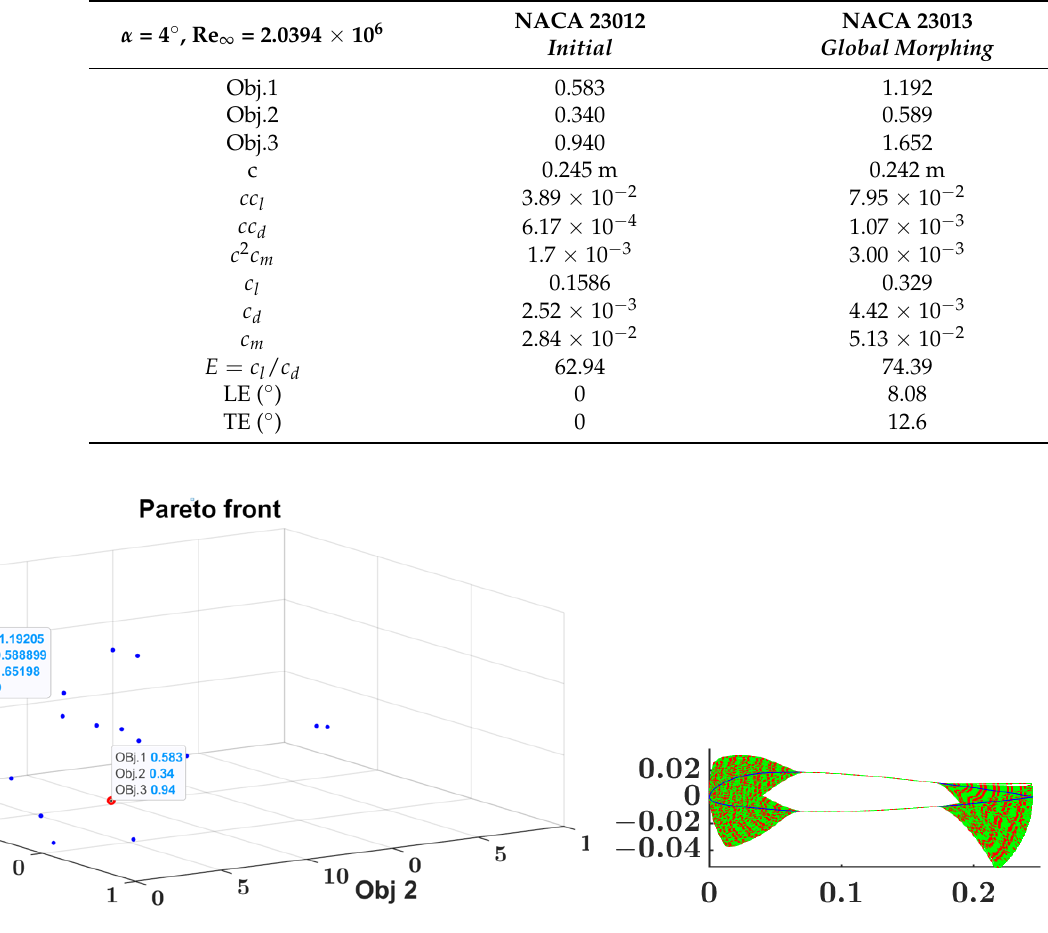
Figure 36. Objective functions Pareto front ( left ) (initial airfoil (redpoint)), airfoil global morphing ( right ).